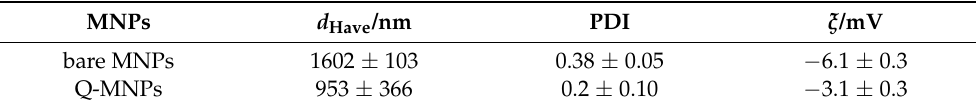
Table 2. Average hydrodynamic diameter of population, polydispersity index (PDI), and zeta potential ( ξ /mV) of bare and quercetin-loaded MNPs in a 2-propanol/H 2 O mixture (Vol.% 65:35) measured at 25 ◦ C.